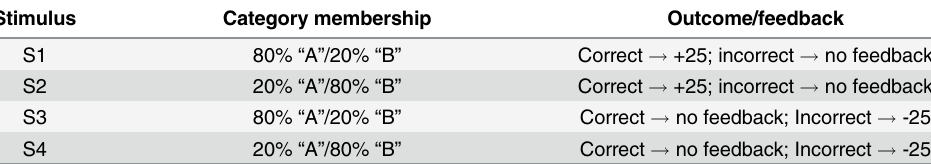
Table 1. Category membership probabilities and outcomes for the four